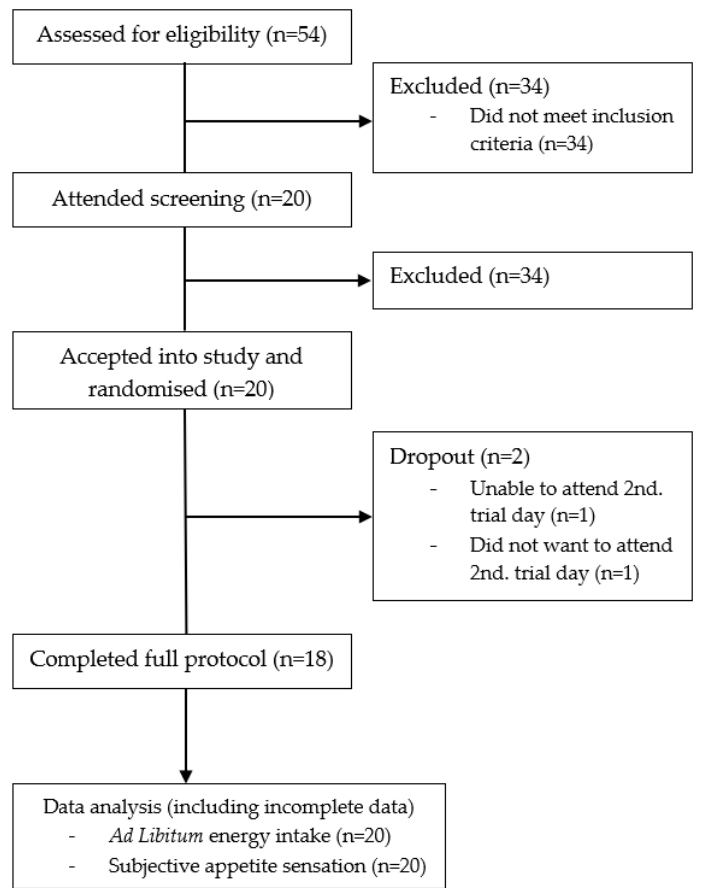
Figure 1. Subject